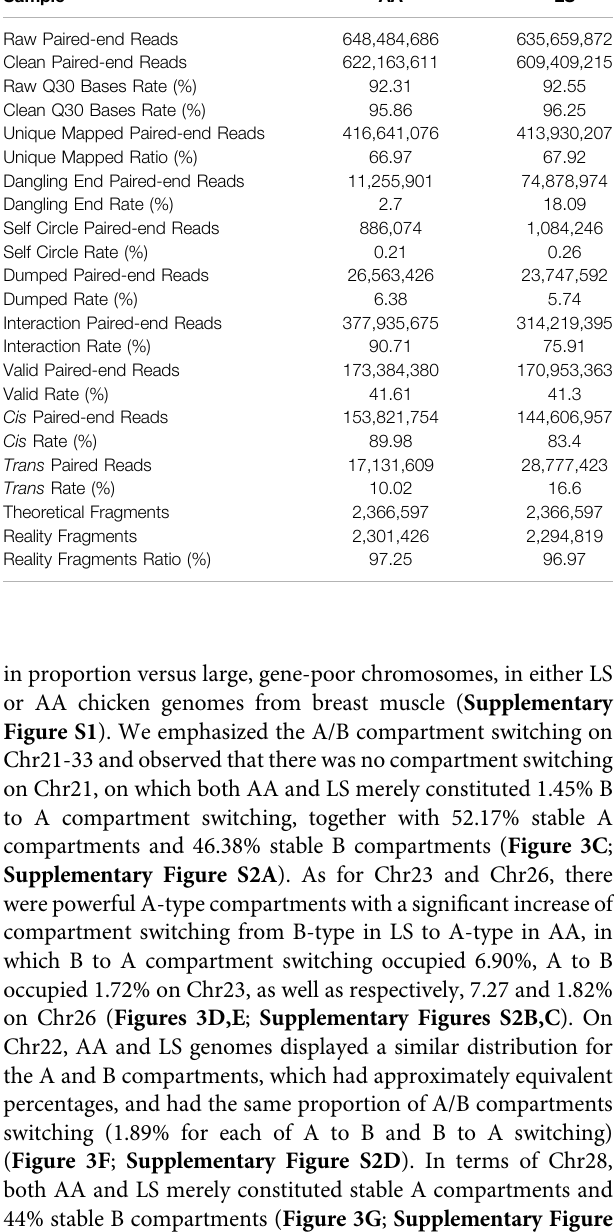
TABLE 2| Characteristics ofthe Hi-C reads from two chicken pectorales libraries. Sample AA LS Raw Paired-end